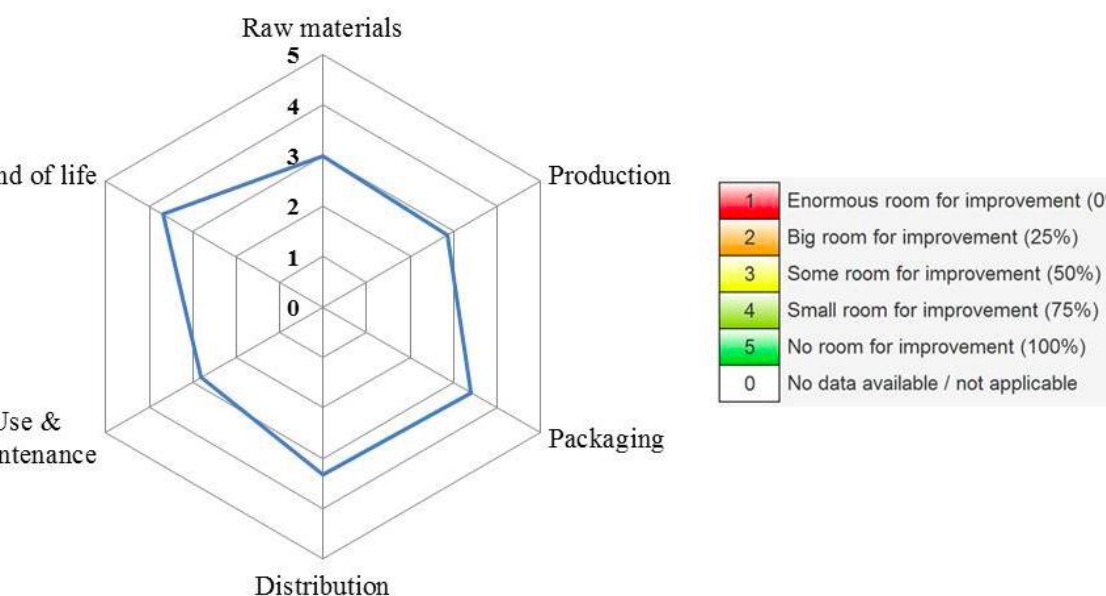
Figure 4. Results of the environmental assessment for a specific case study, including the spider diagram with its assessment